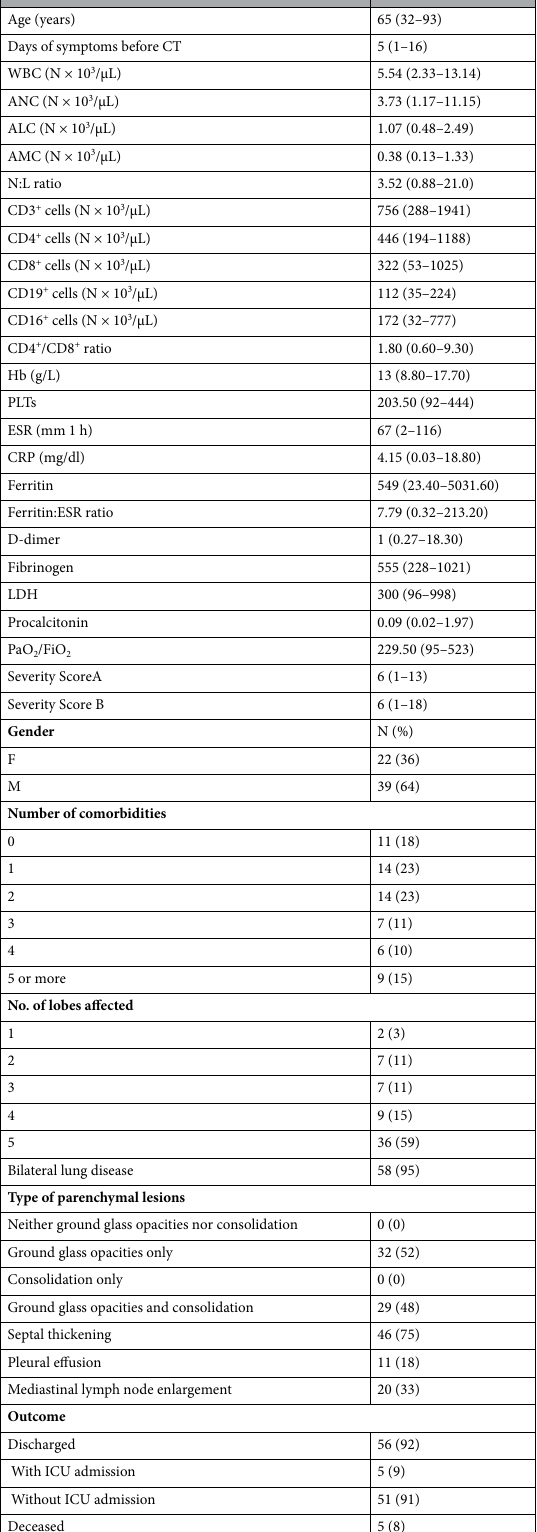
Table 1. Clinical, serological and computed tomography scan features of the study cohort (N = 61). CT computed tomography, WBC white blood cells, ANC absolute neutrophil count, ALC absolute lymphocyte count, AMC absolute monocyte count, N:L neutrophils:lymphocytes, Hb haemoglobin, PLT platelets, ESR erythrocyte sedimentation rate, CRP C reactive protein, LDH lactate dehydrogenase, ICU intensive care